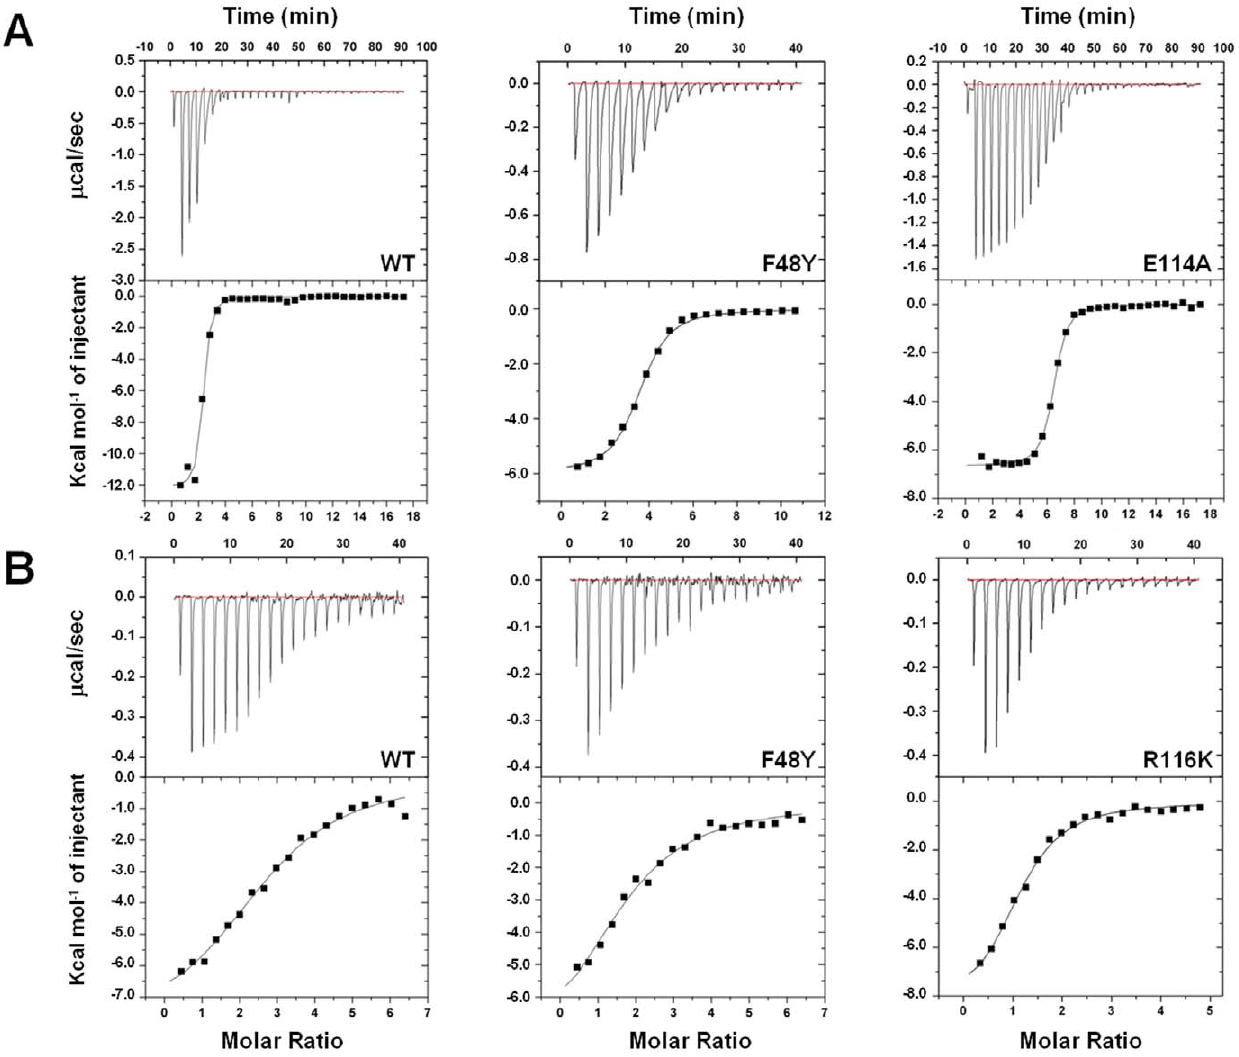
Figure 1. Binding properties of HpSK mutants. Isothermal titration calorimetry data showing, (A) the titration of shikimate into wild-type, F48Y, and E114A, and (B) the titration of NSC162535 into wild-type, F48Y, and R116K. In each panel, the upper portion shows raw data for the titration, and the lower portion shows the normalized, integrated binding isotherm together with the fitted binding curve.